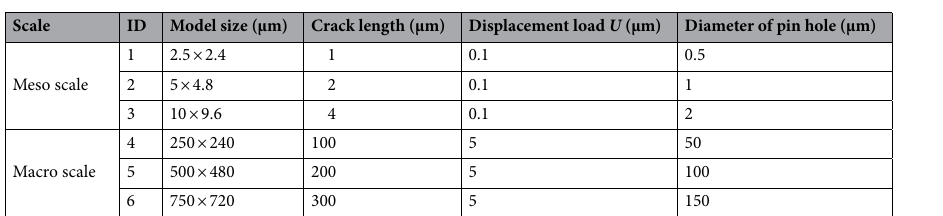
Table 8. Specific dimension information of CT